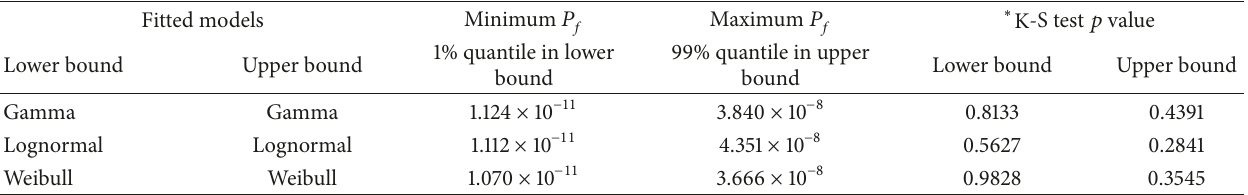
Table 4: Failure probability obtained from selected models.